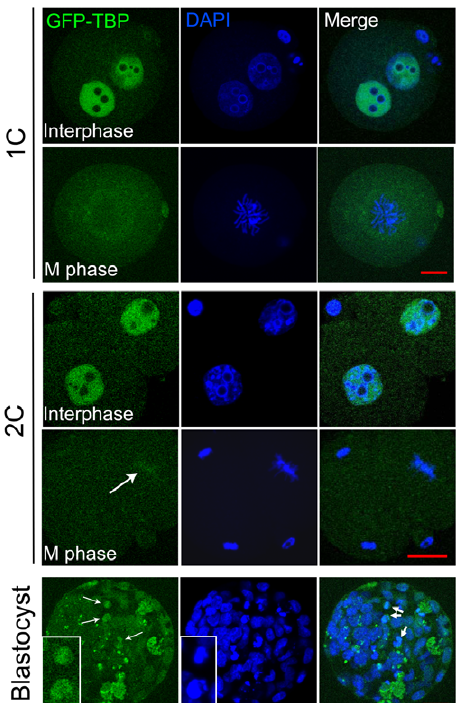
Figure 3. Localization of GFP-TBP in mouse embryos. GFP-TBP signals were found at the nucleus of interphase of the zygotes and 2 cell embryos. In the M phase of zygotes, there was no GFP-TBP expression; In the M phase of 2-cell embryos, a weak GFP-TBP signal was found at the chromosomes; in the blastocyst, GFP-TBP was detected at the chromosomes of M phase blastomeres. Arrow shows the chromosome localization of exogenous TBP expression. Bar=20 m